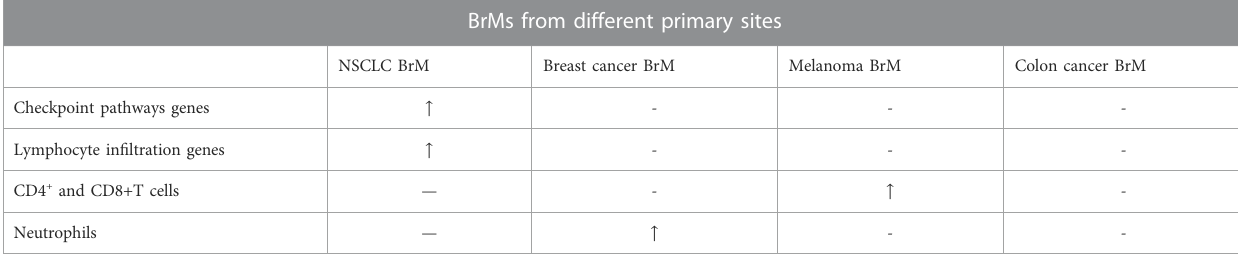
TABLE 1 Comparison between BrMs from different primary sites. Checkpoint pathways genes include genes of TNFRSF9, TNFRSF4, PDCDILG2, IDO1, ICOS, CD274. Lymphocyte in fi ltration genes include genes of TARP, PTPRC, PTPN7, IL10RA, GZMK, CD52, CD2, CCR5, CCL5. “ - ” represents that the value is relatively normal compared with the decreased or increased one. “ / ” means no outcomes available. “ ↑ ” means overexpression. “ ↓ ” means relatively low